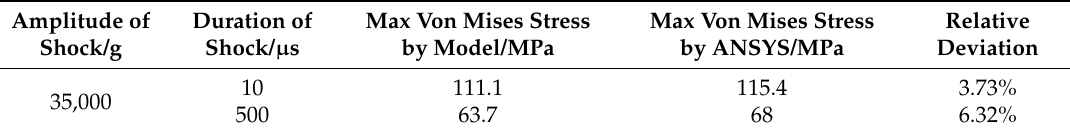
Table 2. Maximum Von Mises equivalent stress of the inductor with auxiliary pillar as calculated by ANSYS and the proposed